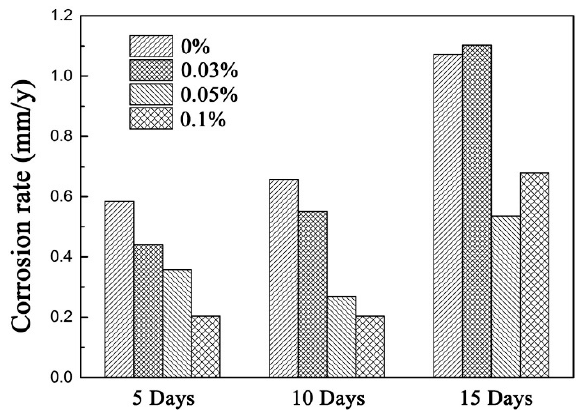
= 0%, 0.03%, 0.05%, 0.1% 6 Sn 5 composite solder: x